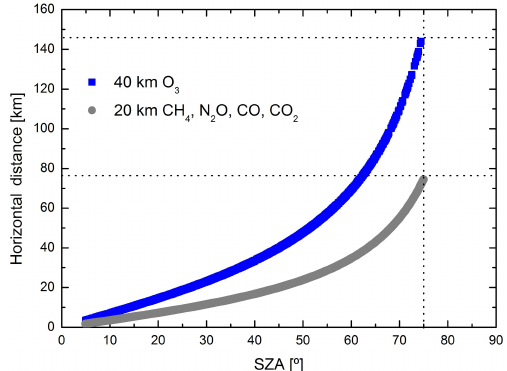
Figure B2. Horizontal distance covered by the FTS observations (in km) versus the solar zenith angle (SZA; in ◦ ), at which they are taken for all the target gases. The dashed lines represent the maximal horizontal